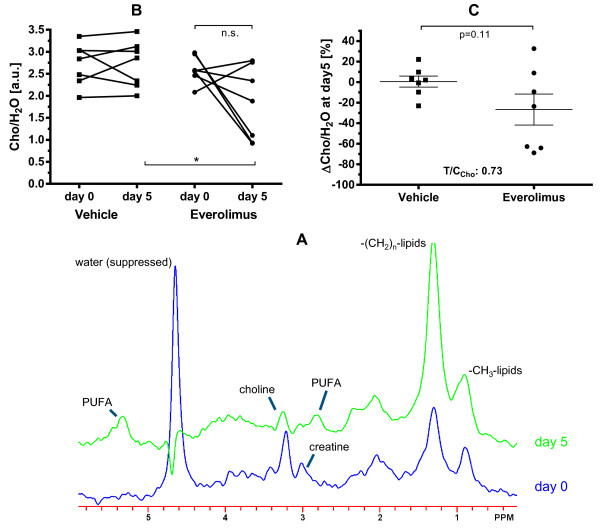
Everolimus decreases the Cho/H2O ratio of RIF-1 tumours. C3H mice bearing RIF-1 tumours were treated with everolimus (10 mg/kg/day) or vehicle for 5 days and the ratio of total choline to (unsuppressed) water (Cho/H2O) in tumours was measured on day 0 and at the endpoint day 5. Panel A shows a 1H-MRS spectrum from a representative RIF-1 tumour before and after treatment with everolimus. Graphs show the individual values for each tumour, n = 7 per treatment group (B) and the mean ± SEM fractional change ΔCho/H2O for each treatment (C), where *p < 0.05 as shown.